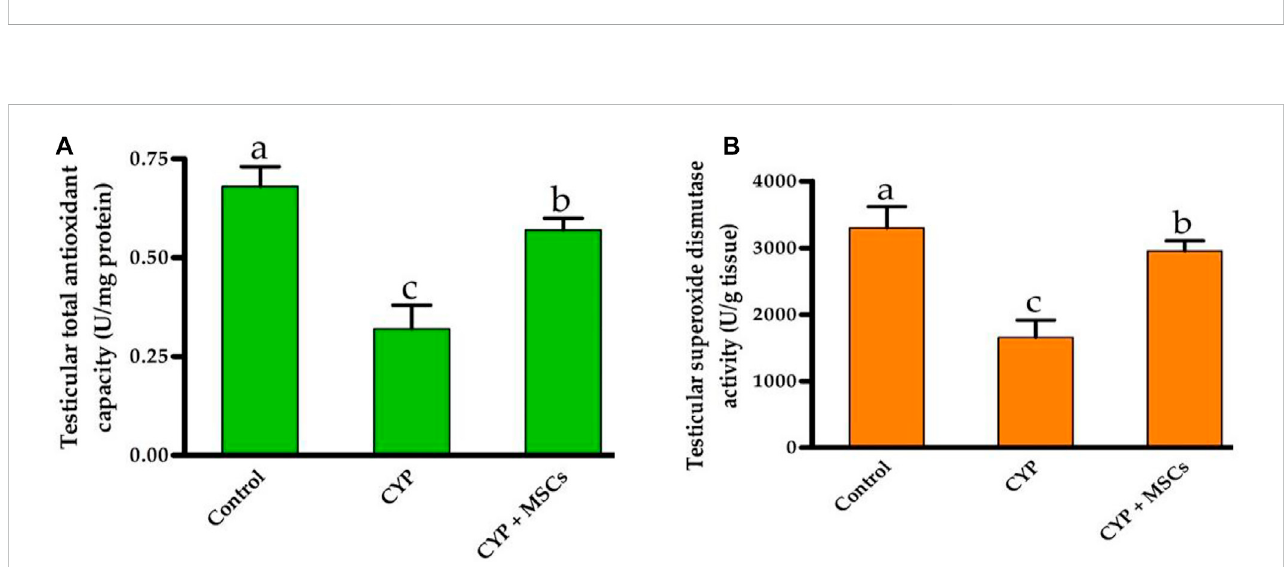
FIGURE 3 In fl uences of CYP with/without MSCs transplantation on testicular oxidative stress markers; (A) testicular total antioxidant capacity, (B) testicular superoxide dismutase activity. Data described as mean ± SD (n = 6). DMRTs show that bars with various letters are substantially different at p = 0.05.